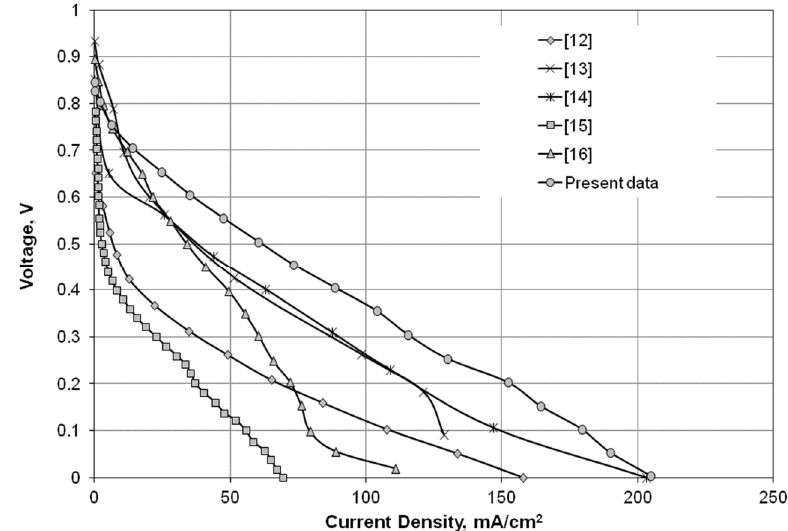
Figure 3. Performance comparison of air-breathing microfluidic fuel cells between the present study (1.0-M HCOOH, 0.5 mL/min) and other published data